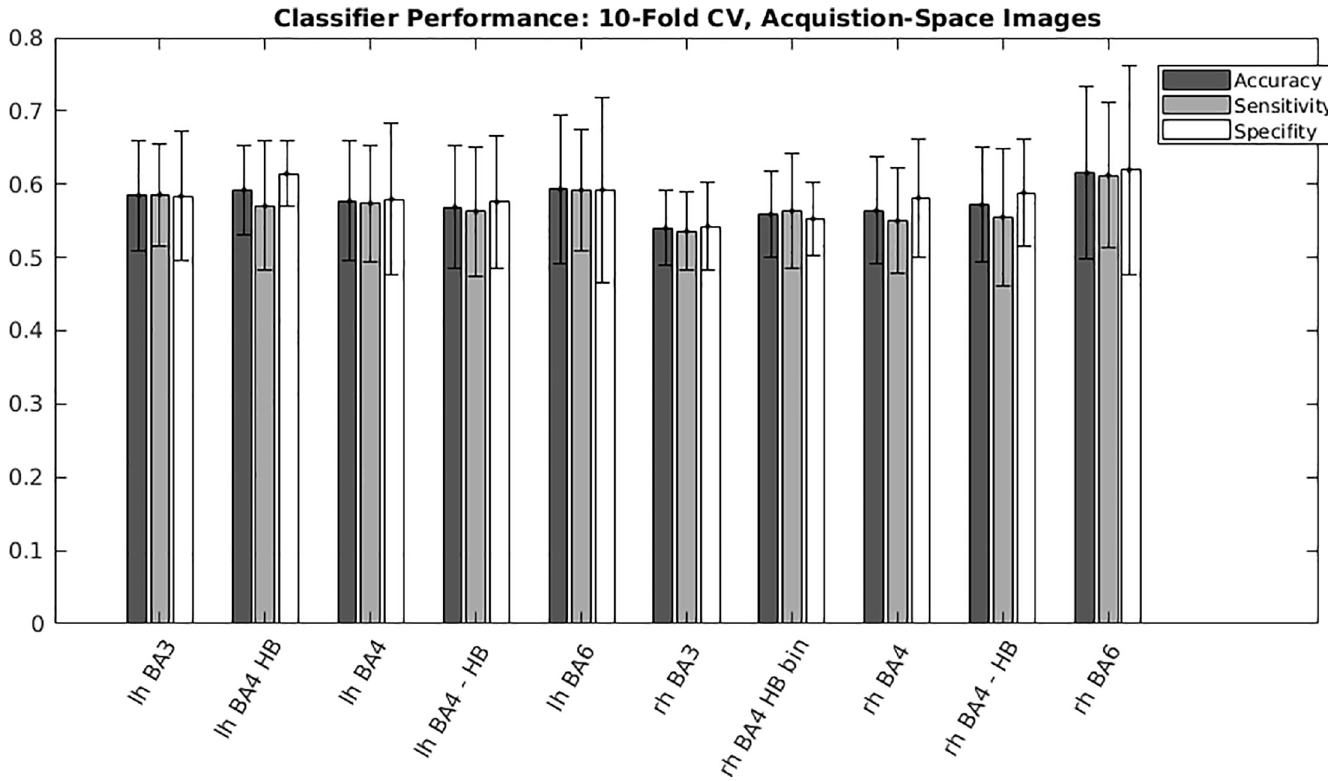
Fig 5. Acquisition-space images: Regional classifier performance in terms of accuracy, sensitivity, and specificity. Brodmann’s areas ROI masks were derived from participant-specific cortical parcellations of native acquisition images, ROIs were investigated in both hemispheres for primary somatosensory cortex (BA3), primary motor cortex (BA4), and pre-motor and supplementary motor areas (BA6). The participant-specific BA4 masks were further subdivided into participant- and hemisphere-specific “hand knob” masks